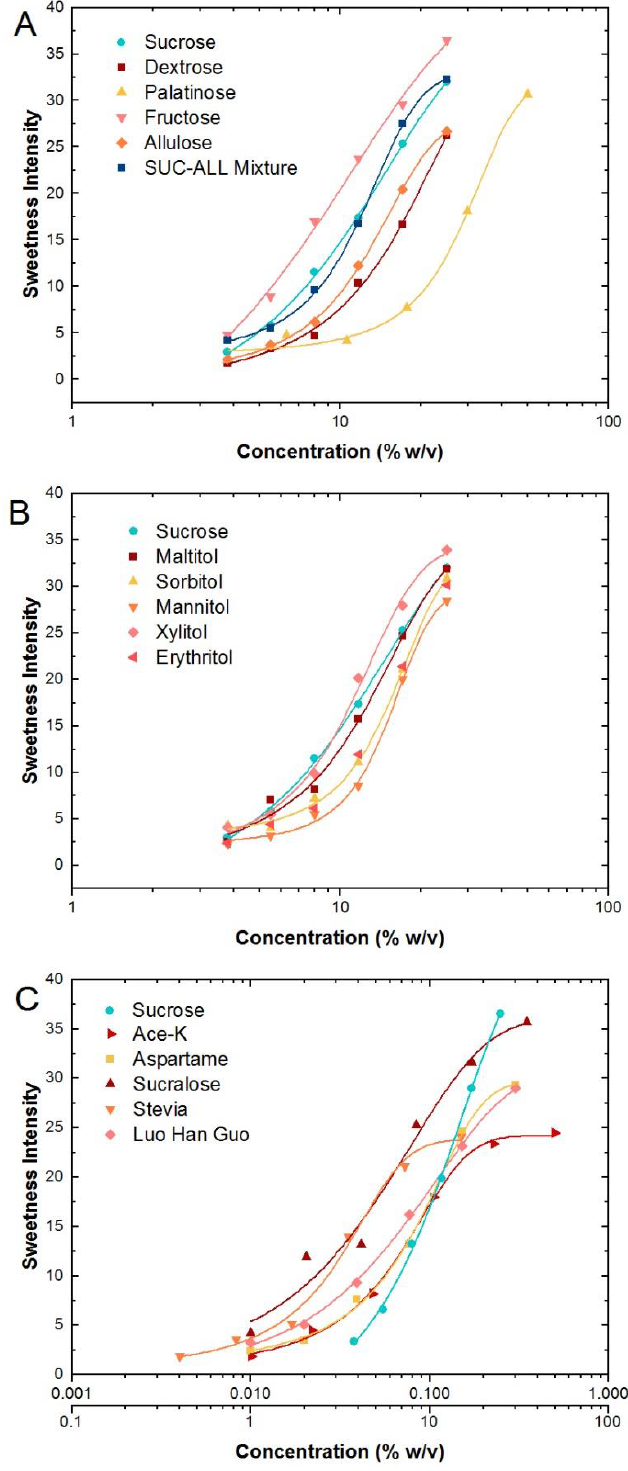
Figure 1 . Sweetness intensity with concentration for ( A ) saccharide, ( B ) polyol and ( C ) non-nutritive sweeteners (sucrose is plotted using the secondary x-axis below (0.1 – 100% w/v )).